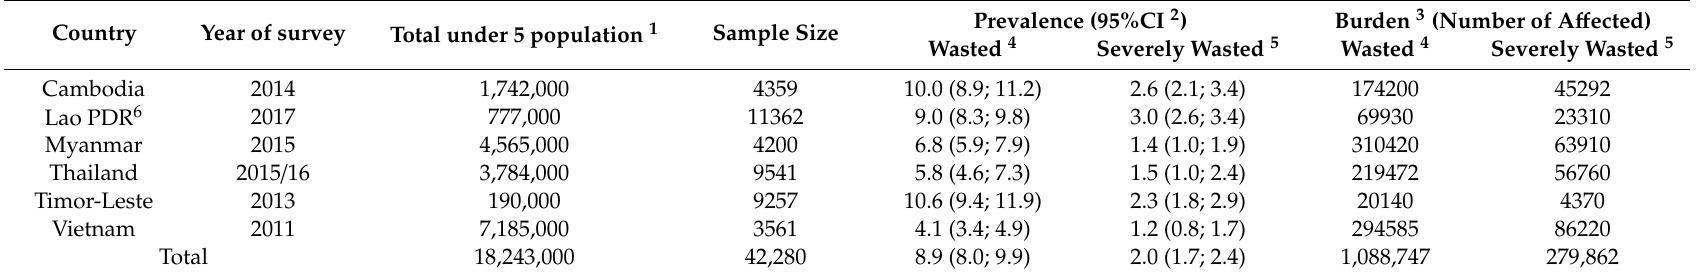
Table 2. Pooled and by country prevalence and burden of wasting and severe